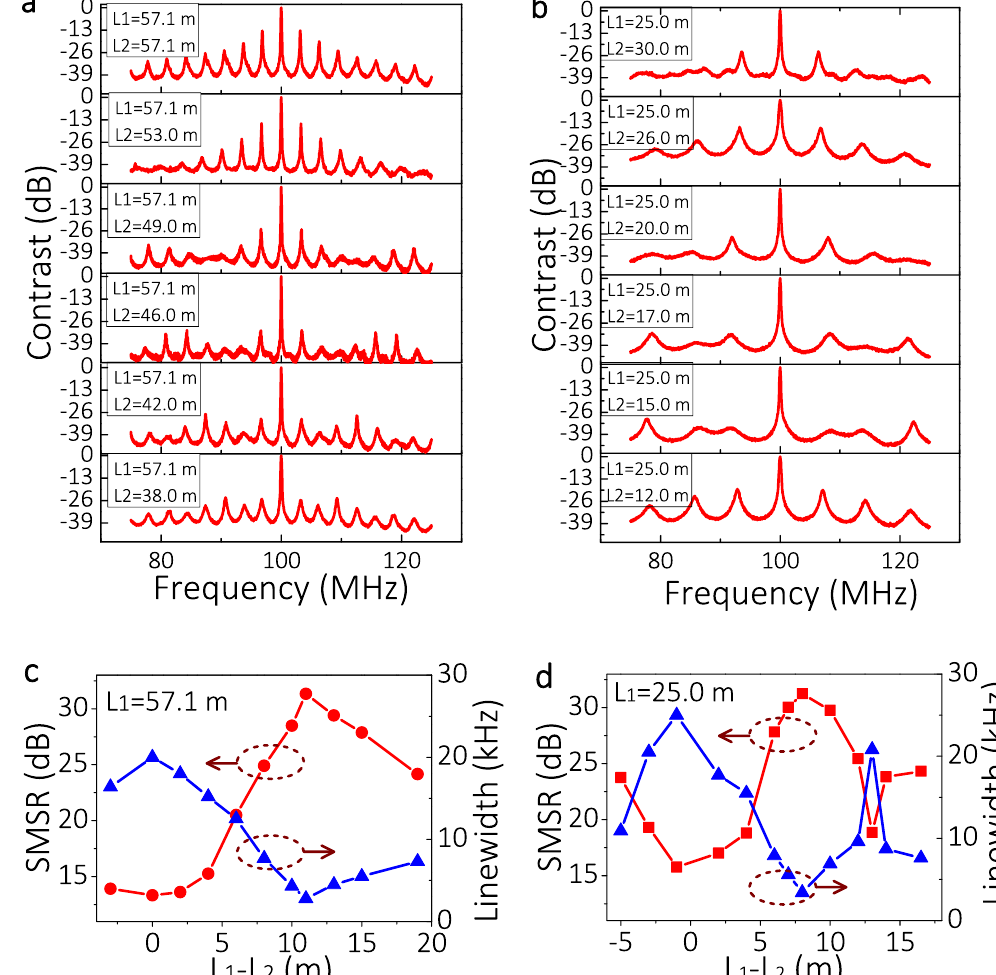
Figure 5. ( a , b ) Detected normalized power spectra for selected different combinations of feedback lengths with DCFS. ( c , d ) The overall SMSR (red points) from the detected normalized power spectra and their corresponding linewidth (blue points) from the SCELD